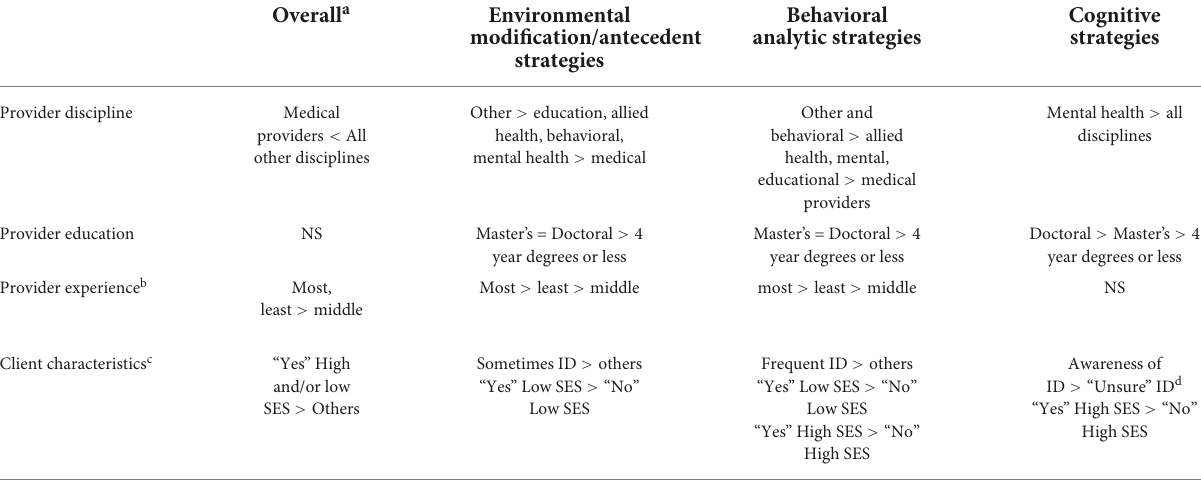
TABLE 4 Summary of